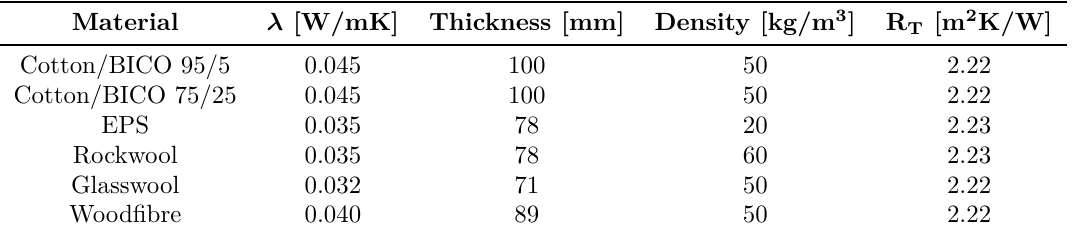
Table 1. Properties of the analysed insulation